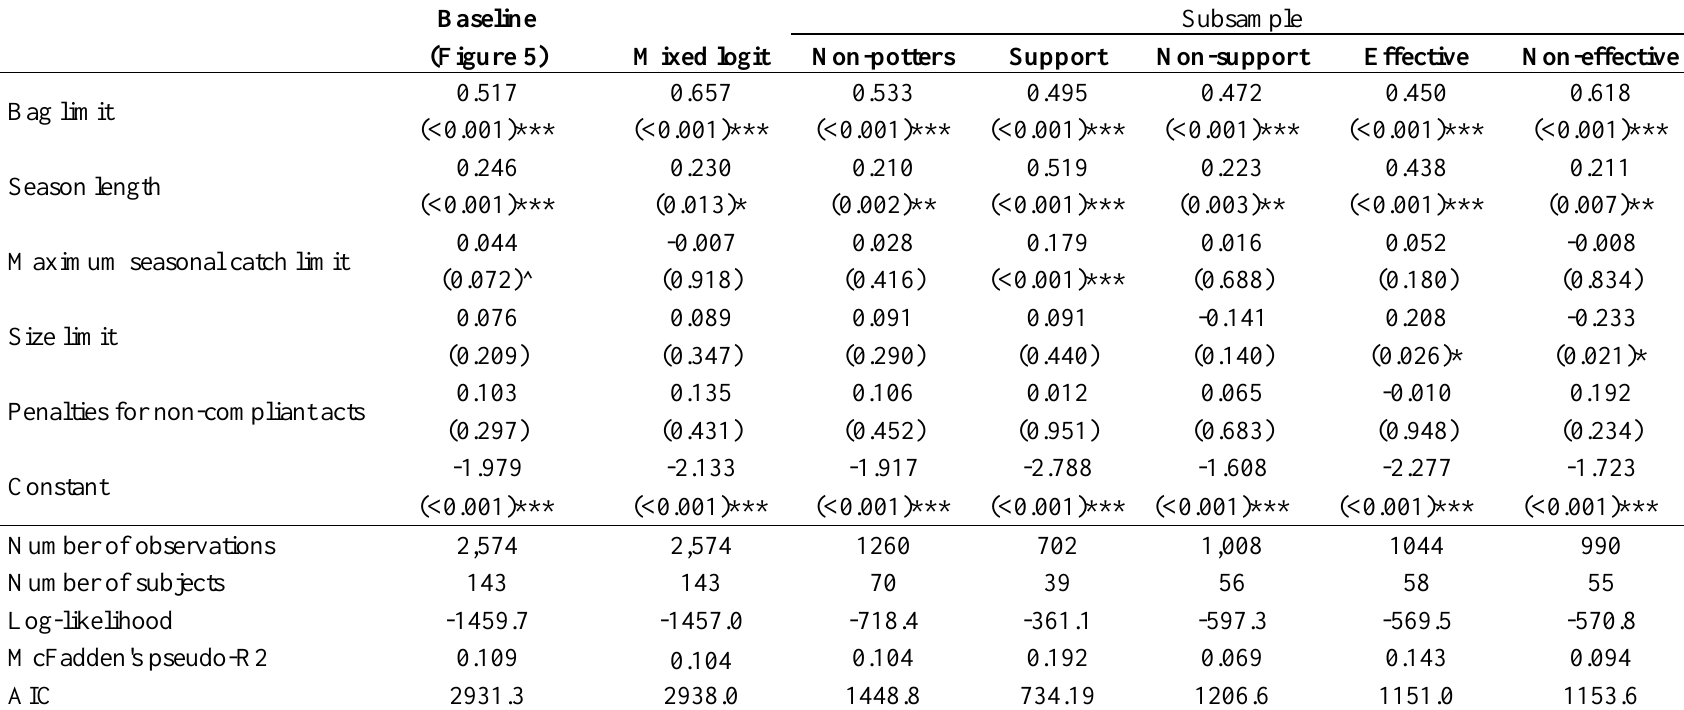
Table A.2. Sensitivity analysis: different model